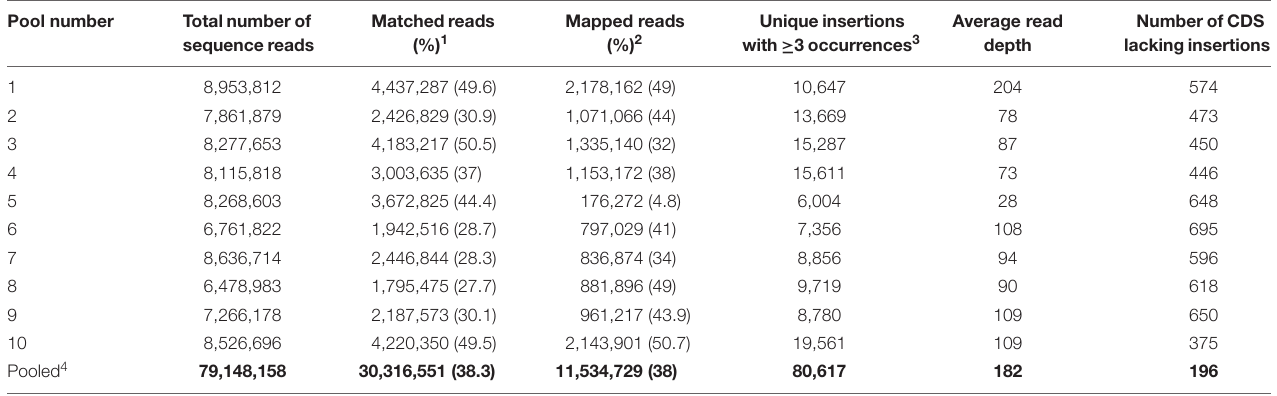
TABLE 2 | Evaluation of sequences generated from 10 pools of Streptococcus uberis